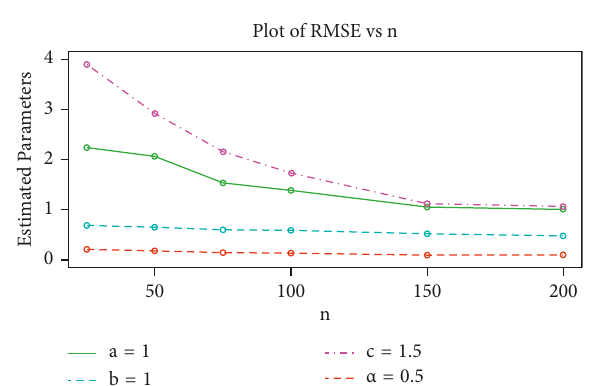
Figure 10: The plots of RMSEs for the ExEW parameters in set